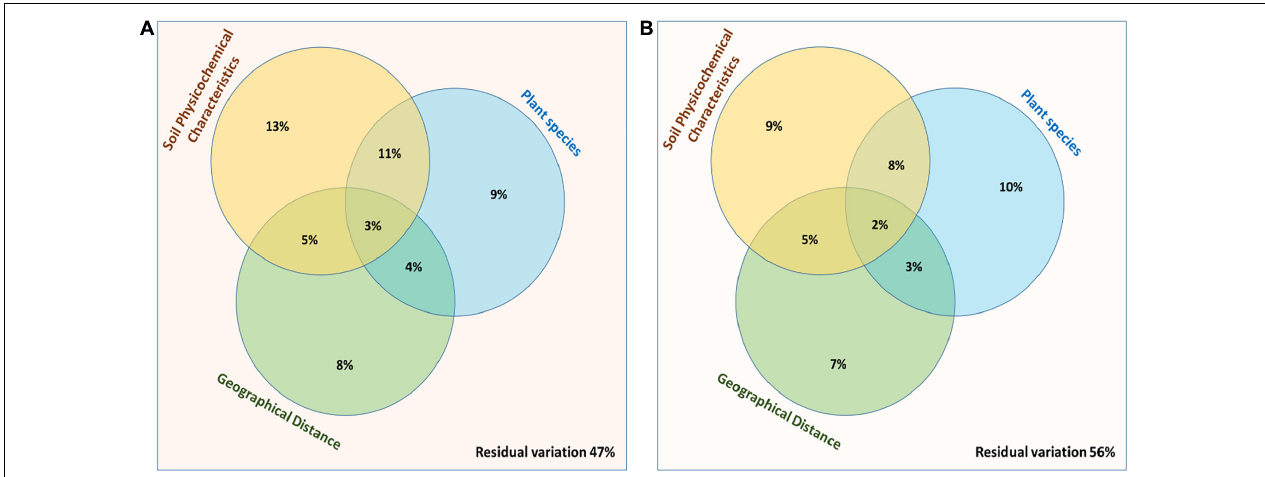
FIGURE 7 | Partitioning between the biological variations in the bacterial community structure. Three explanatory matrices were used here, containing variables pertaining to plant species, soil physicochemical characteristics and geographical distance on composition of (A) Rhizosphere and (B) Root endosphere